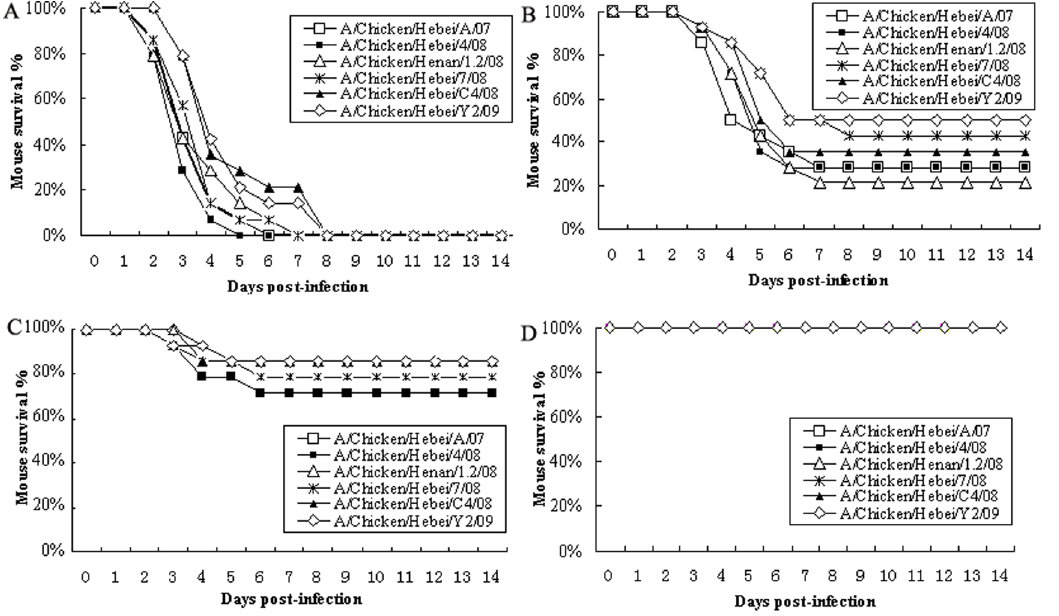
Figure 5. Survival percentage of mice after H9N2 viral infection. Groups of mice (n=14) were inoculated i.n. with each of six H9N2 viruses at a dose of 10 7 EID 50 ( A ), 10 6 EID 50 ( B ), 10 5 EID 50 ( C ) or 10 4 EID 50 ( D ), respectively. Percent survival was observed daily for 14 days.